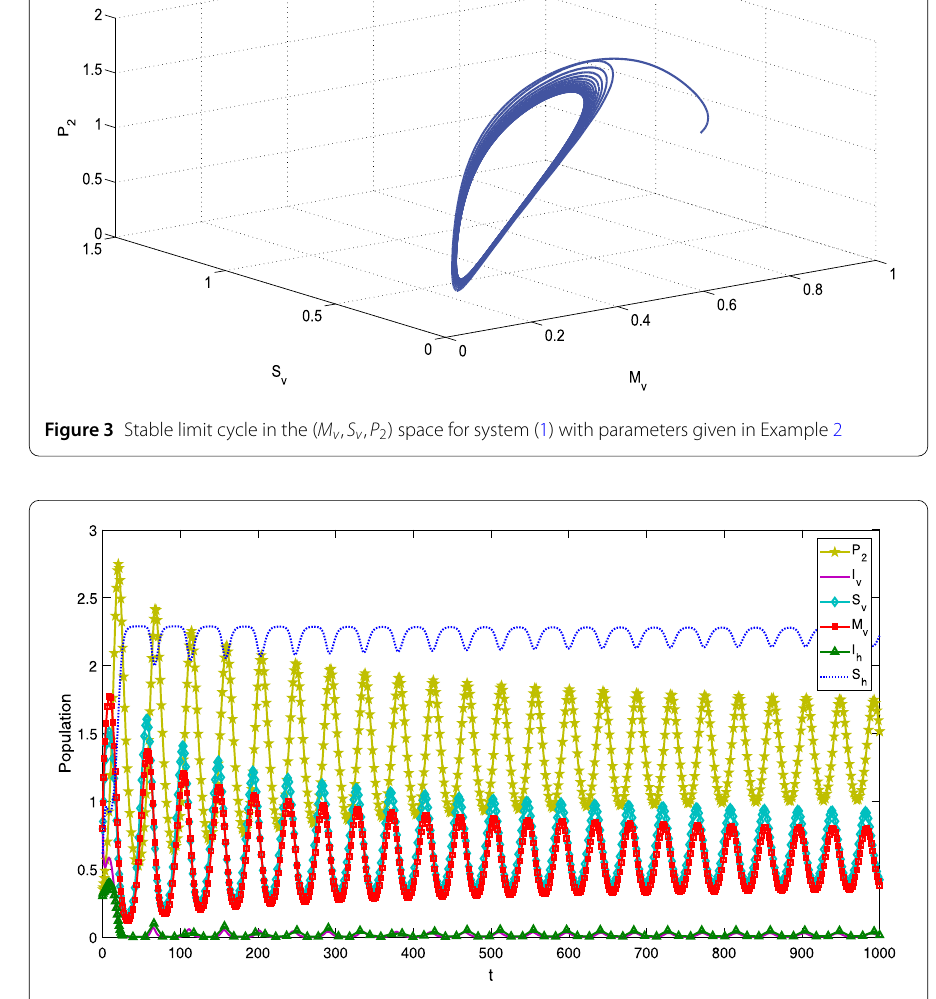
Figure 4 Solution curves of system (1) with parameters given in Example